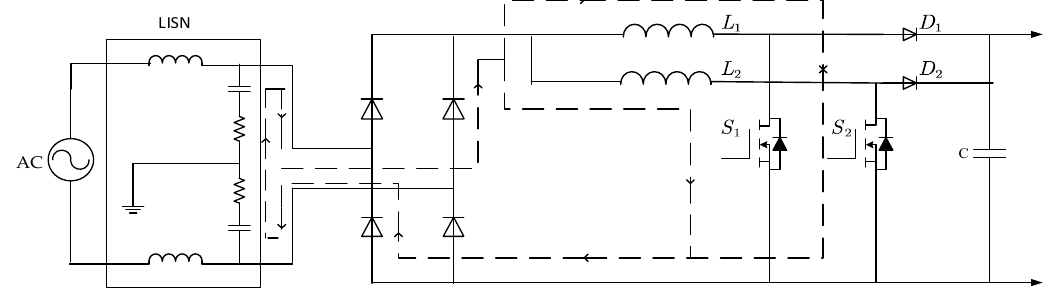
Figure 2. DM circulation in the interleaved PFC.